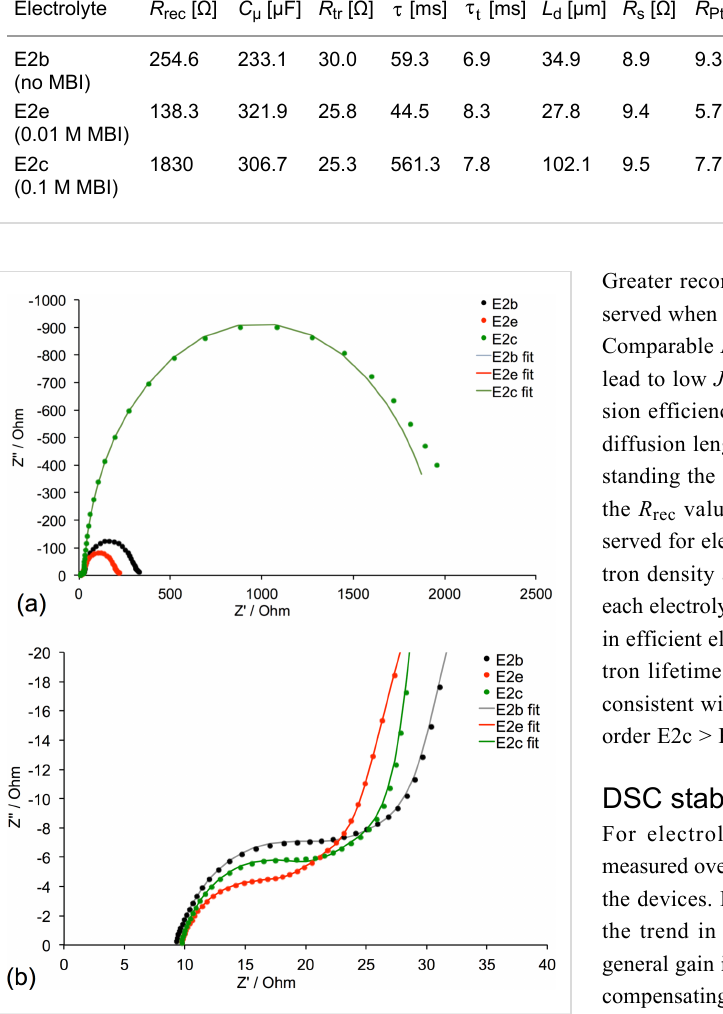
Figure 7: (a) Nyquist plots of DSCs with E2b, E2e and E2c elec- trolytes. (b) Expansion of the high frequency region. Experimental data are represented by dots and solid lines represent fitted